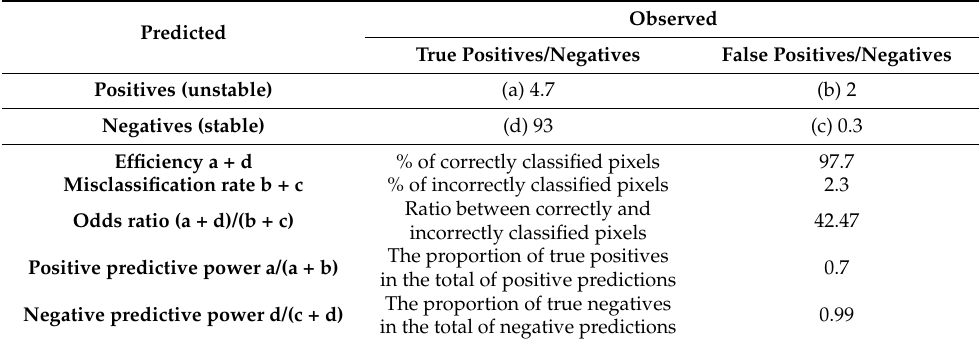
Table 3. Prediction errors (% of correctly and incorrectly predicted pixels) and accuracy